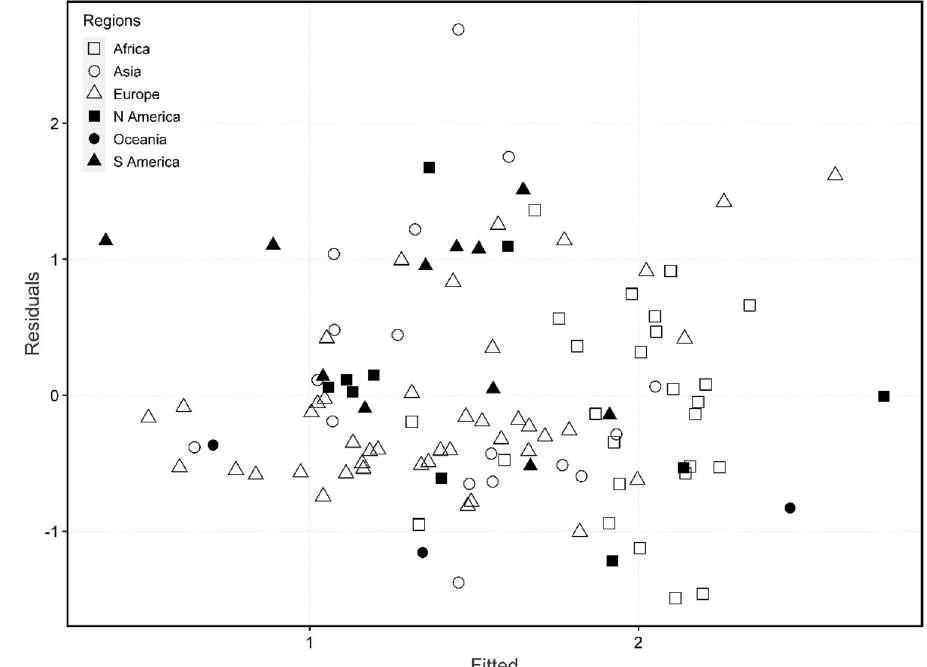
Fig. 2 Residual plot of the regression